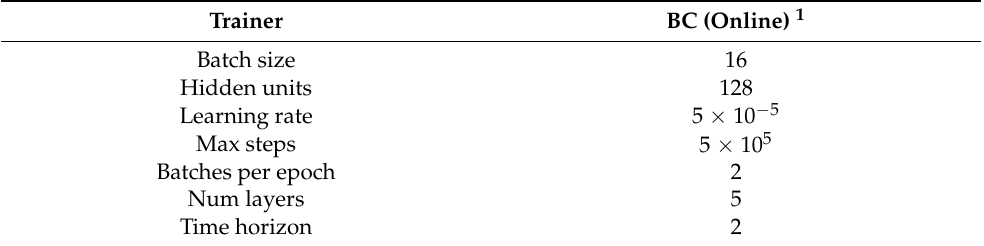
Table 9. Configuration hyperparameters for the IA trained by reinforcement through the BC